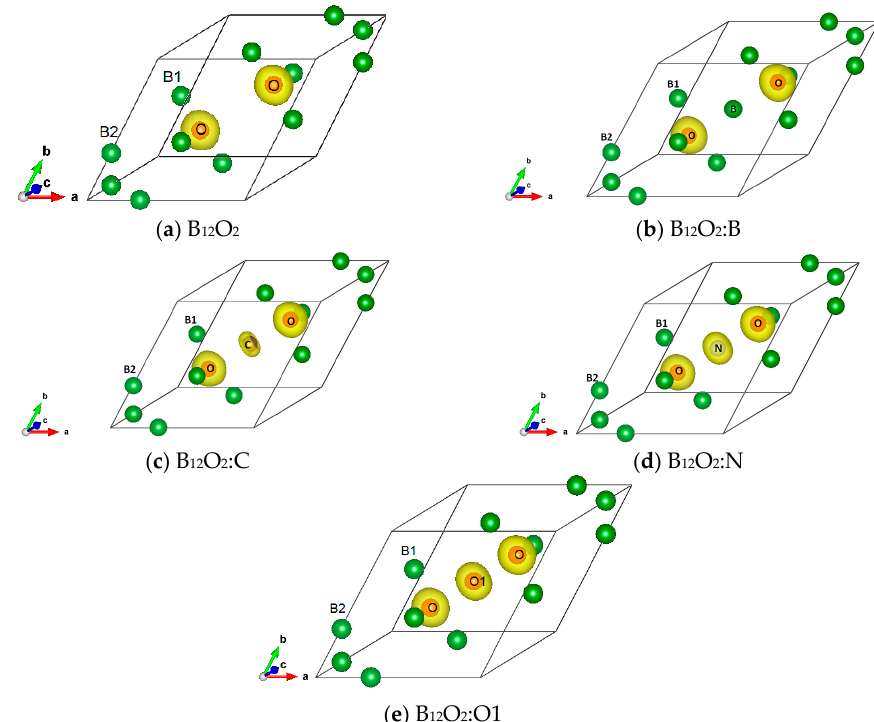
Figure 3. (color). Charge density projected onto the atomic constituents in ( a ) B 12 O 2 , ( b ) B 12 O 2 :B, ( c ) B 12 O 2 :C, ( d ) B 12 O 2 :N, and ( e ) B 12 O 2 :O1.